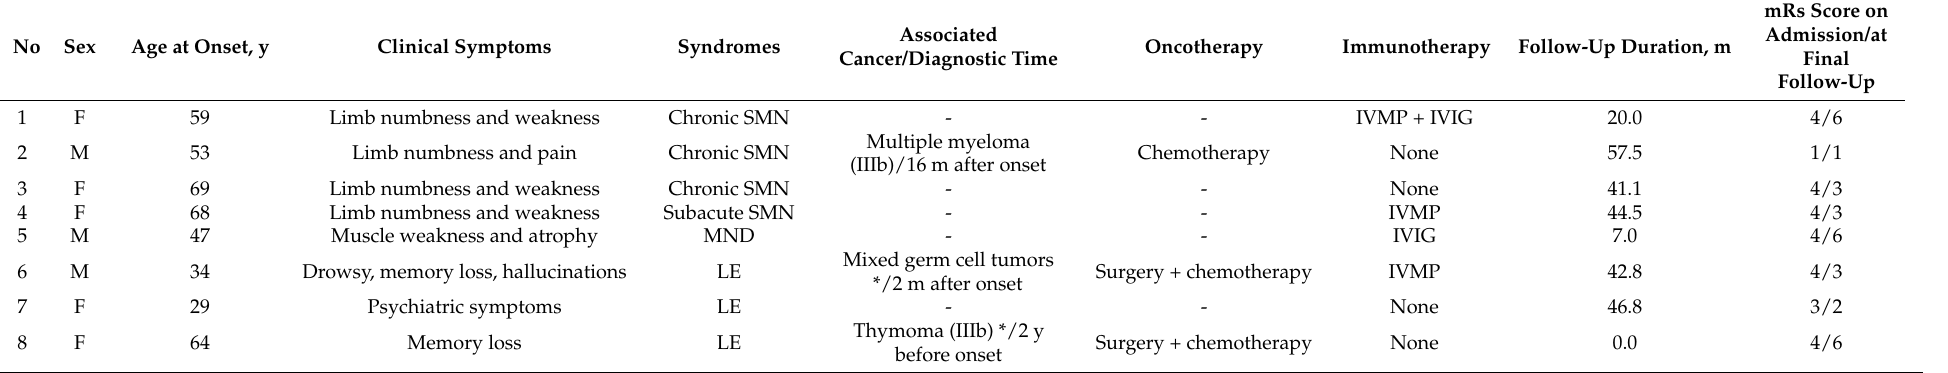
Table 1. Clinical characteristics and outcomes of 8 patients with anti-Ma2 antibody-associated paraneoplastic neurologic